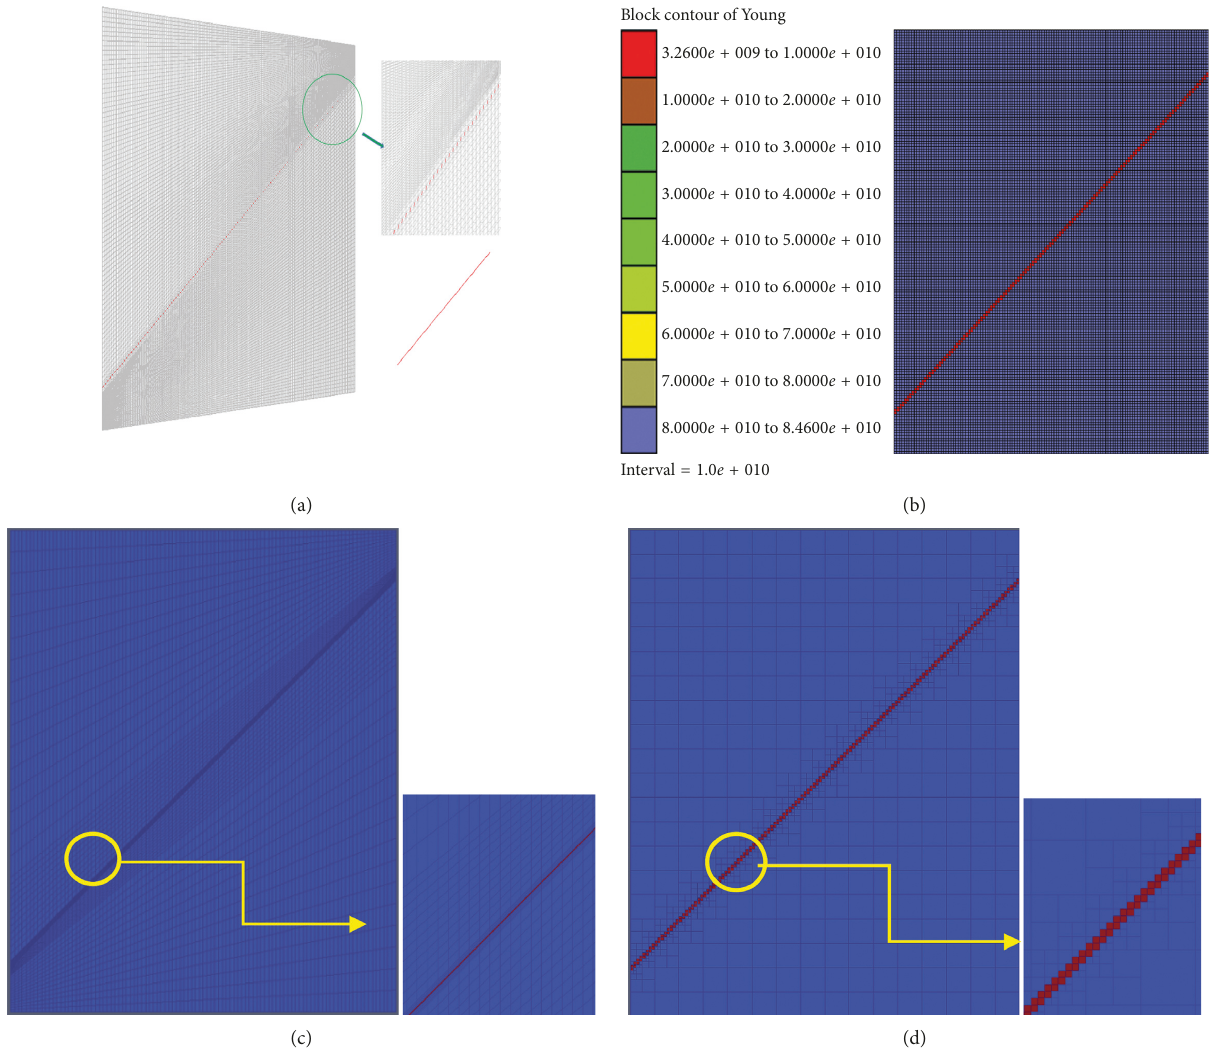
Figure 5: Modeling of the oriented fracture with inclination angle θ � 45 ° in the medium using the interface element model (a), uniform mesh model with the global refinement technique (b), the conformed mesh model (c), and the nonuniform mesh obtained from the local refinement technique with hanging nodes